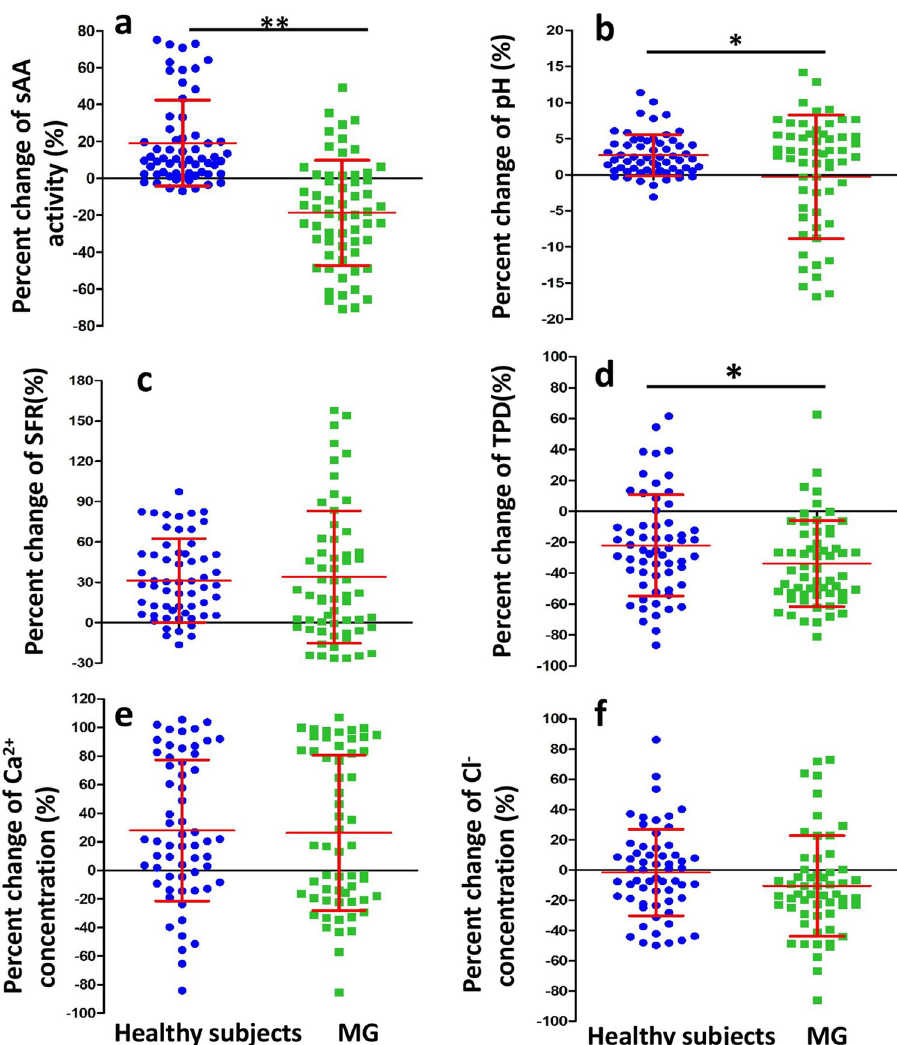
Fig 1. Salivary indicator changes after acid stimulation in HCG and MG. (a) : sAA activity, (b) : pH value, (c) : SFR, (d) : TPD, (e) : Ca 2+ concentration, (f) : Cl - concentration. Percent change reflects the extent of salivary secretion respond to acid stimulation and is calculated as [(value post-acid stimulation)—(value pre-acid stimulation)]/(value pre-acid stimulation) × 100%. The independent sample t test was applied at �� p < 0.01 and � p < 0.05; data are expressed as mean ±